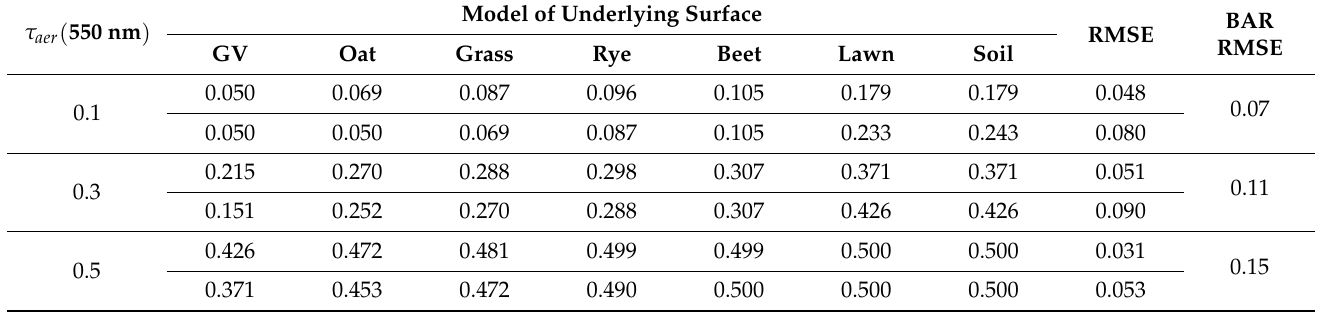
Table 5. RMSE of reflectance retrieval in the MS spectral channels for dark (upper numbers) and bright (lower numbers) surfaces. Solar Zenith Angle